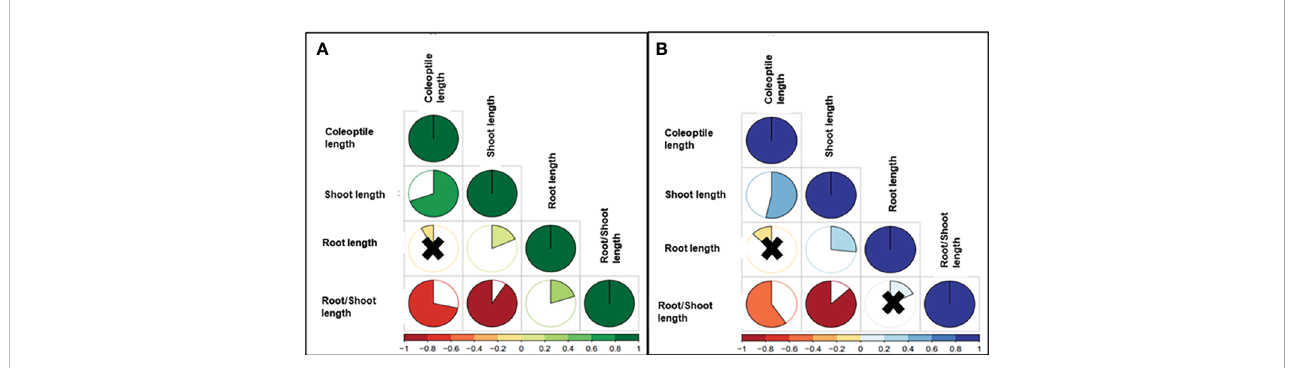
FIGURE 2 Pearson Correlation Coef fi cients of BLUEs values of the studied traits between (A) control and (B) drought in wheat genotypes. The degree of signi fi cance for all correlations was P<0.001. The color re fl ects the strength of the correlation. Black crosses indicate non-signi fi cant